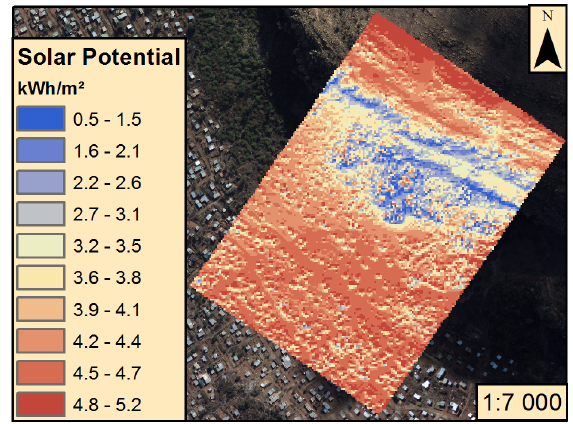
Figure 6. Solar radiation model for Alaska derived from the 1m